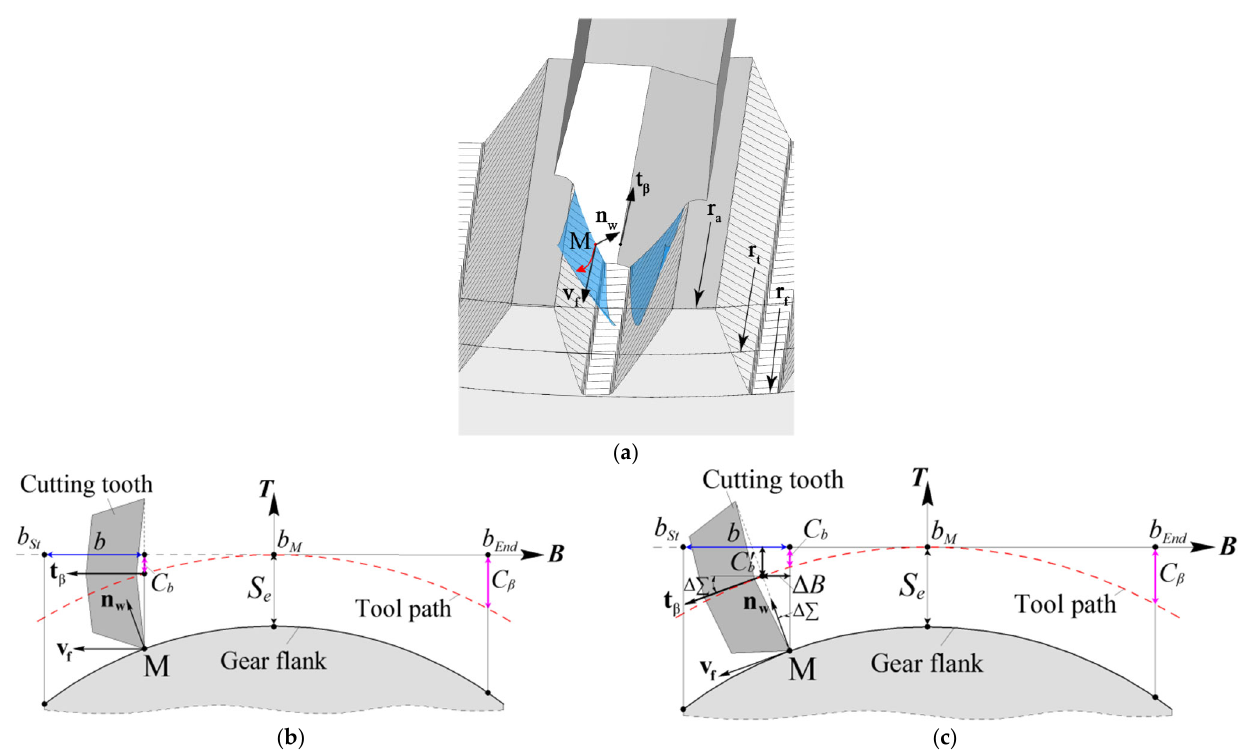
Figure 2. Skiving methods for lead crowning gear. ( a ) gear tooth flank enveloped by the cutting tooth, ( b ) general method of the skiving, ( c ) method of the skiving with alterable shaft angle.